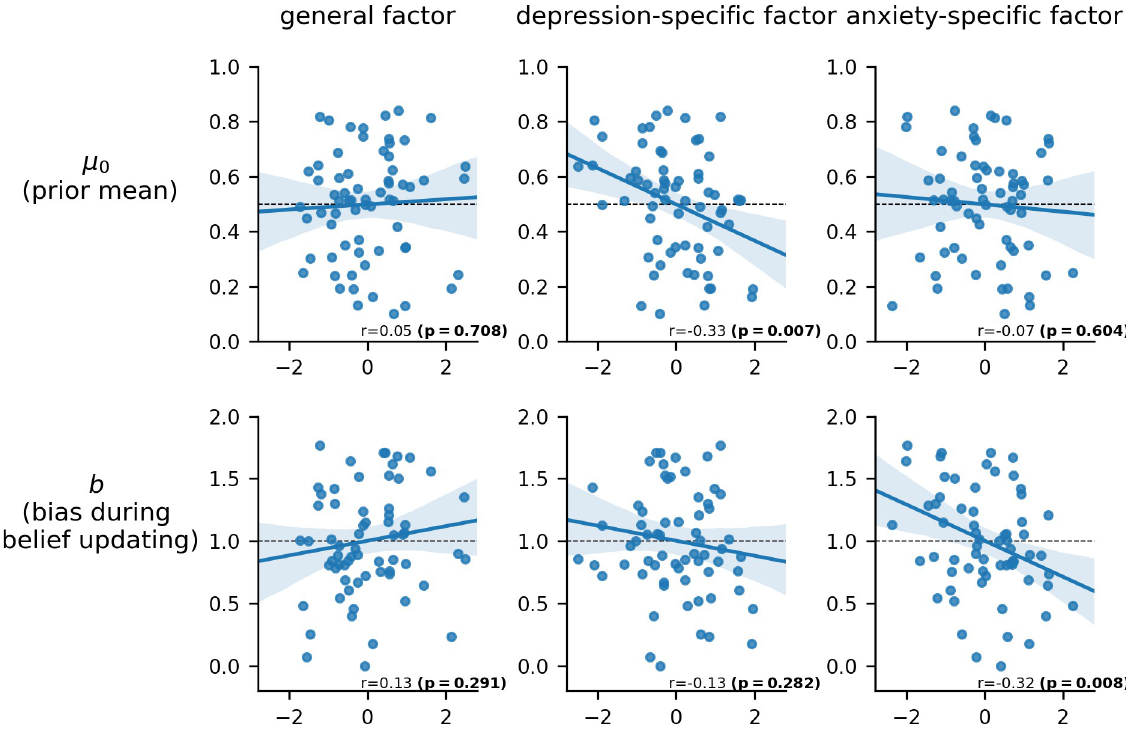
Fig 2. Relationship between parameter estimates for the prior mean ( μ 0 ) and bias in belief updating ( b ) and depression-specific and anxiety-specific factor scores. Participants’ standardized scores for the general factor, anxiety-specific factor and depression-specific factor (x axes) are plotted against parameter estimates for the prior mean ( μ 0 ) and bias in belief updating ( b ), obtained using the winning model: Model 3 the “biased RW” model. μ 0 is the estimated mean of the participant’s belief distribution at the start of the feedback period and b represents bias in updating in response to positive or negative feedback ( b > 1 corresponds to a positive bias, whereas b < 1 corresponds to a negative bias). P-values for Pearson correlations were obtained using two-tailed permutation-tests with 10,000 samples.